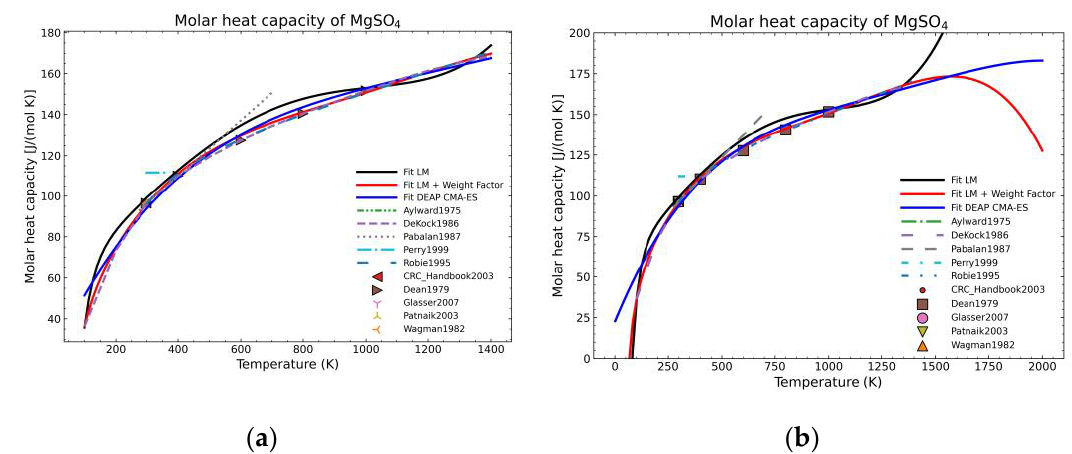
Figure 5. Comparison of the different fit results of MgSO 4 showing: ( a ) literature points region; ( b ) extended range until 2000 K.